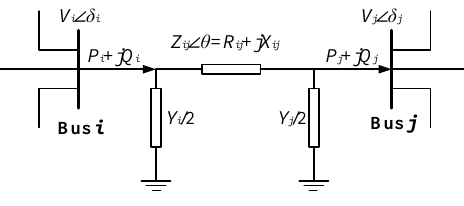
Figure 1. Two bus power system model.